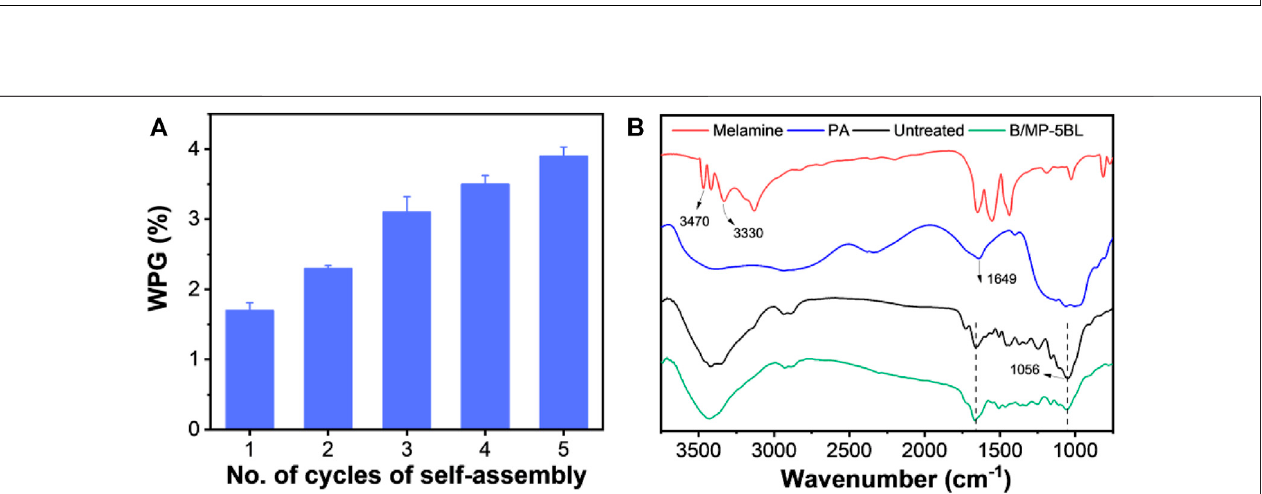
FIGURE 2 | WPG of treated bamboo with different numbers of assembling cycles (A) and ATR-FTIR of untreated and treated bamboo (B) .